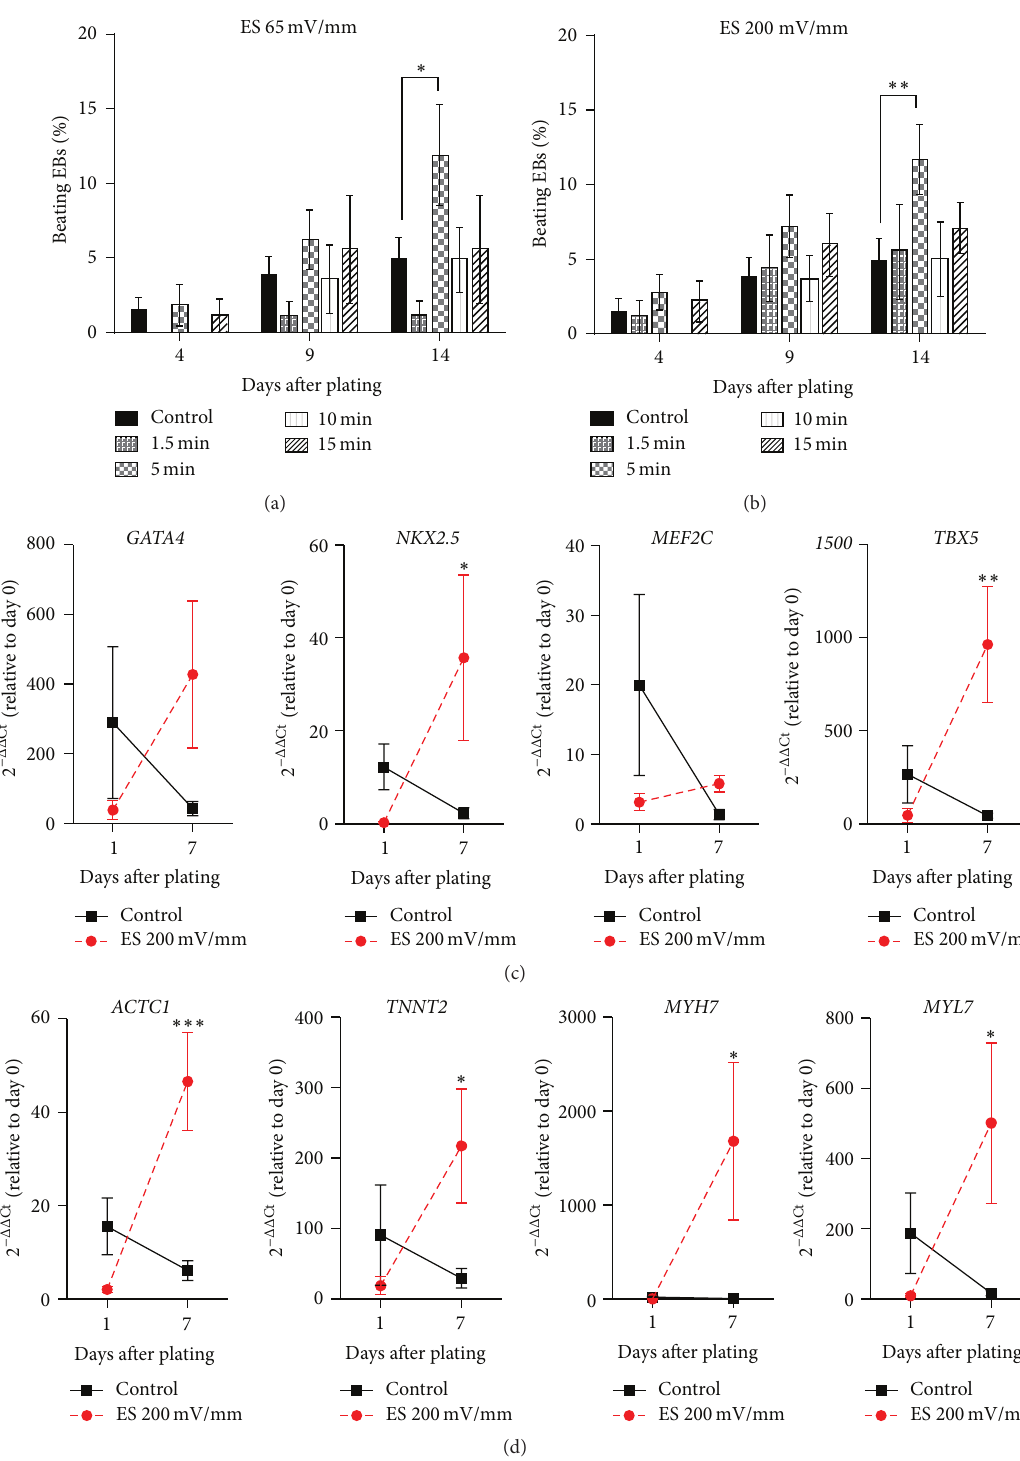
Figure 3: Acute electrical stimulation enhances cardiac differentiation of iPS(Foreskin)-2 cell line. (a-b) The effect of acute electrical stimulation at 65 mV/mm (a) or 200 mV/mm (b) on cardiac differentiation of human iPS(Foreskin)-2 cell line ( 𝑛 = 5 –15 independent experiments). (c-d) Quantitative RT-PCR analysis for the expression of cardiac transcription factors (c) and cardiac contractile muscle proteins (d) in electrically stimulated and control EBs at days 0, 1, and 7 after electrical stimulation ( 𝑛 = 7 independent experiments). Data are expressed as mean ± SEM. ∗ 𝑝 < 0.05 , ∗∗ 𝑝 < 0.01 , and ∗∗∗ 𝑝 < 0.001 by one-way (a-b) or two-way (c-d) ANOVA with the Bonferroni post hoc